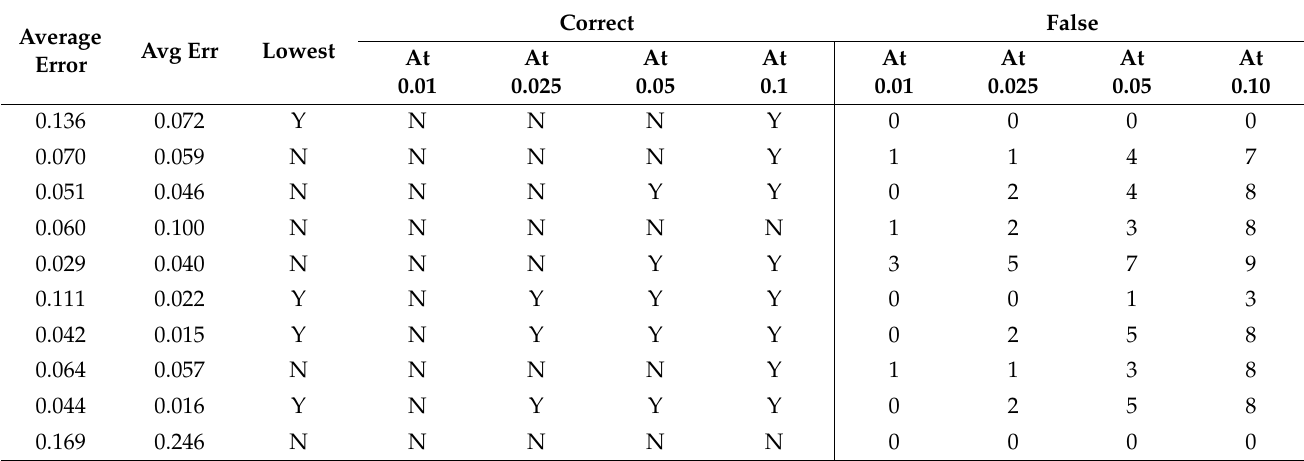
Table A200. Set 3, trials 21–30 summary data (average actual PR values).